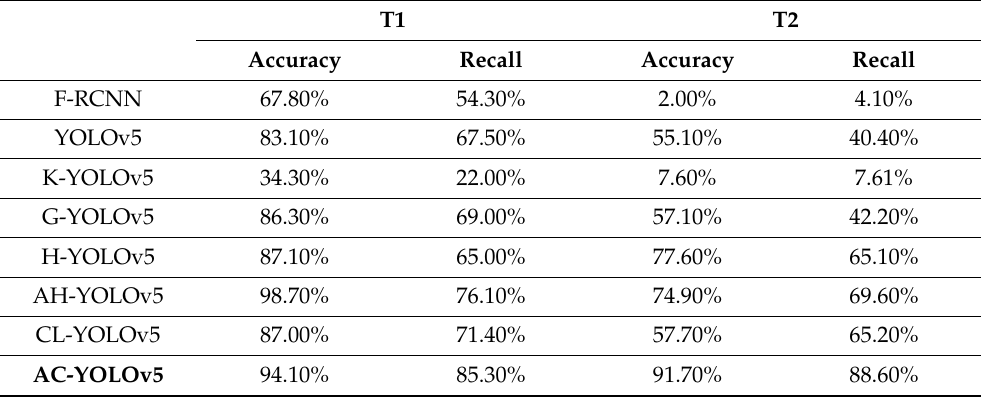
Table 1. The experimental results on T1 and